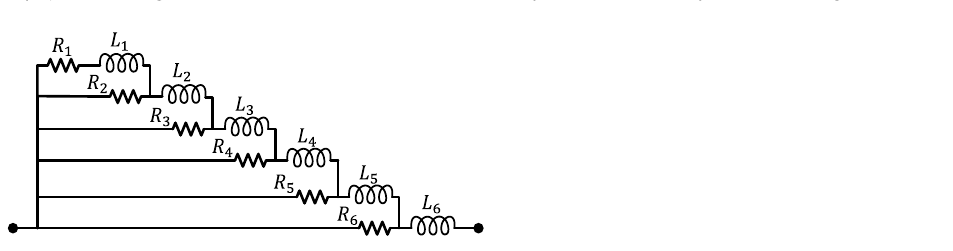
Figure 15. Ladder circuits with six layers are implemented in the MCTL model of stator windings. Table 6. Elements of ladder circuits with six layers (R (Ω), L (H)) to represent the frequency-depend- ent self-resistances and -inductances of different turns in the MCTL model.